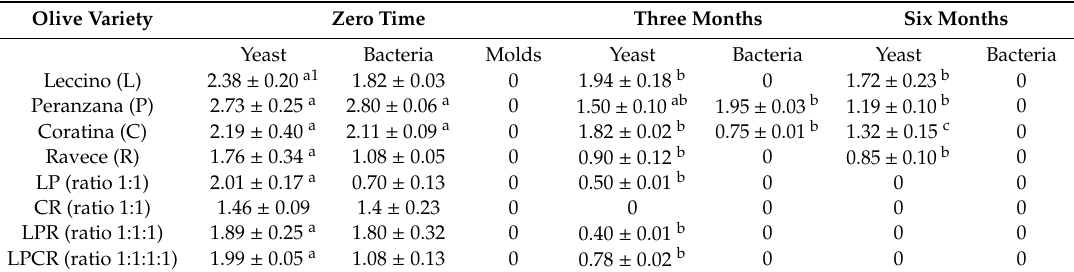
Table 3. Microbiological analysis of monovarietal and blended extra virgin olive oils (EVOOs) during